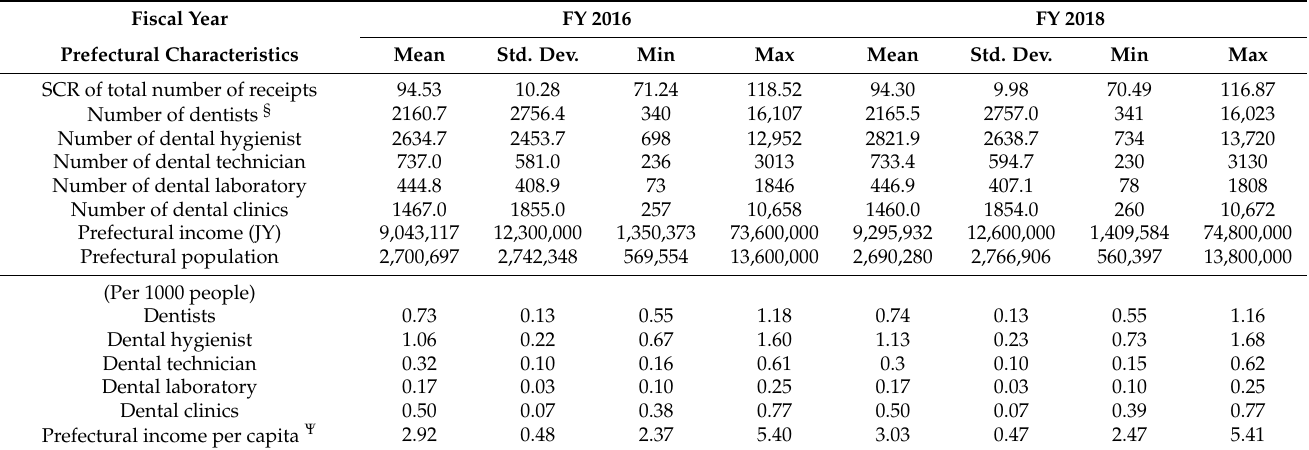
Table 1. The prefectural characteristics in FY2016 and FY2018.